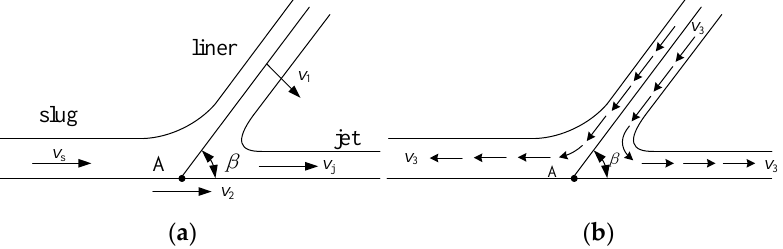
Figure 3. Reactive composite jet formation process ( a ) static coordinate system ( b ) and dynamic coordinate system.